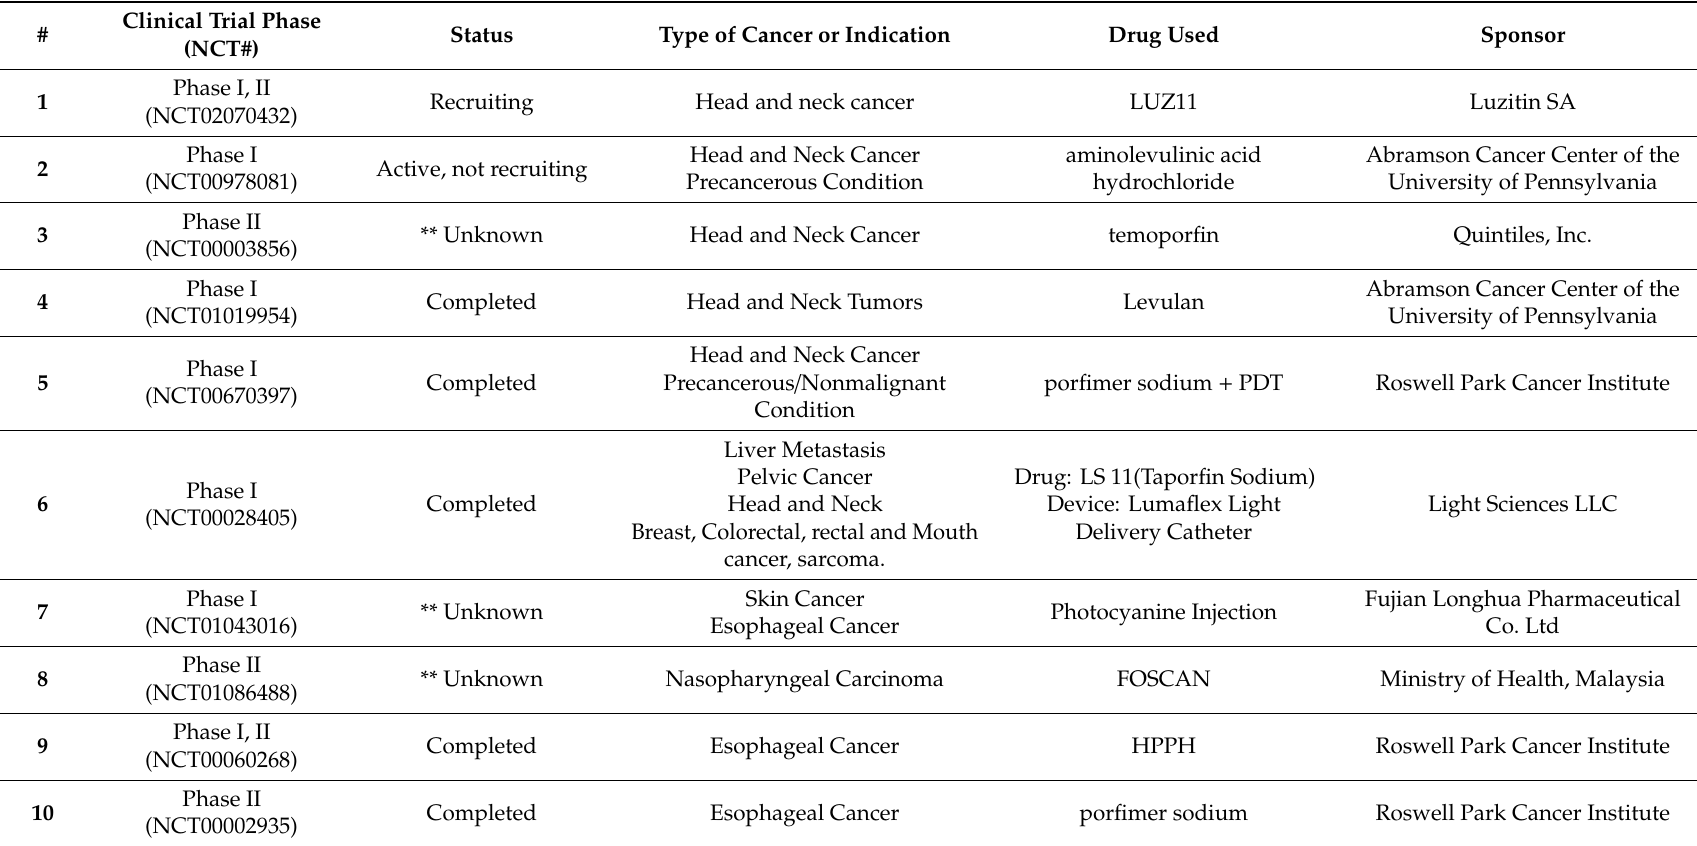
Table 2. Clinical trials of photodynamic therapy of head and neck cancer and gastrointestinal tract